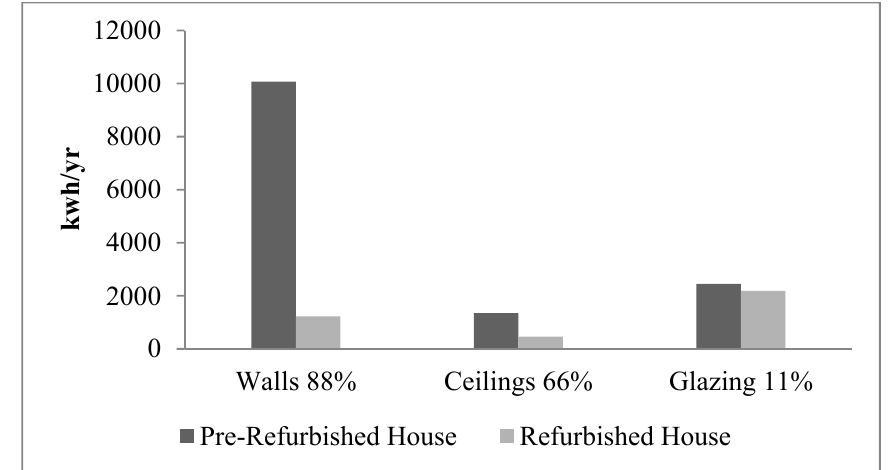
Figure 10. Typical heat losses from pre and post refurbished building envelope components of the terraced house, showing % reduction.